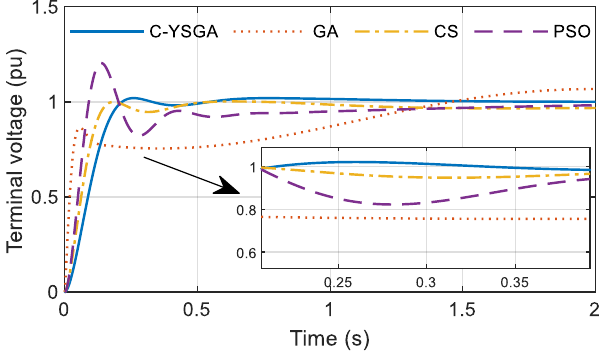
Figure 12. Step response of the AVR system using different algorithms.